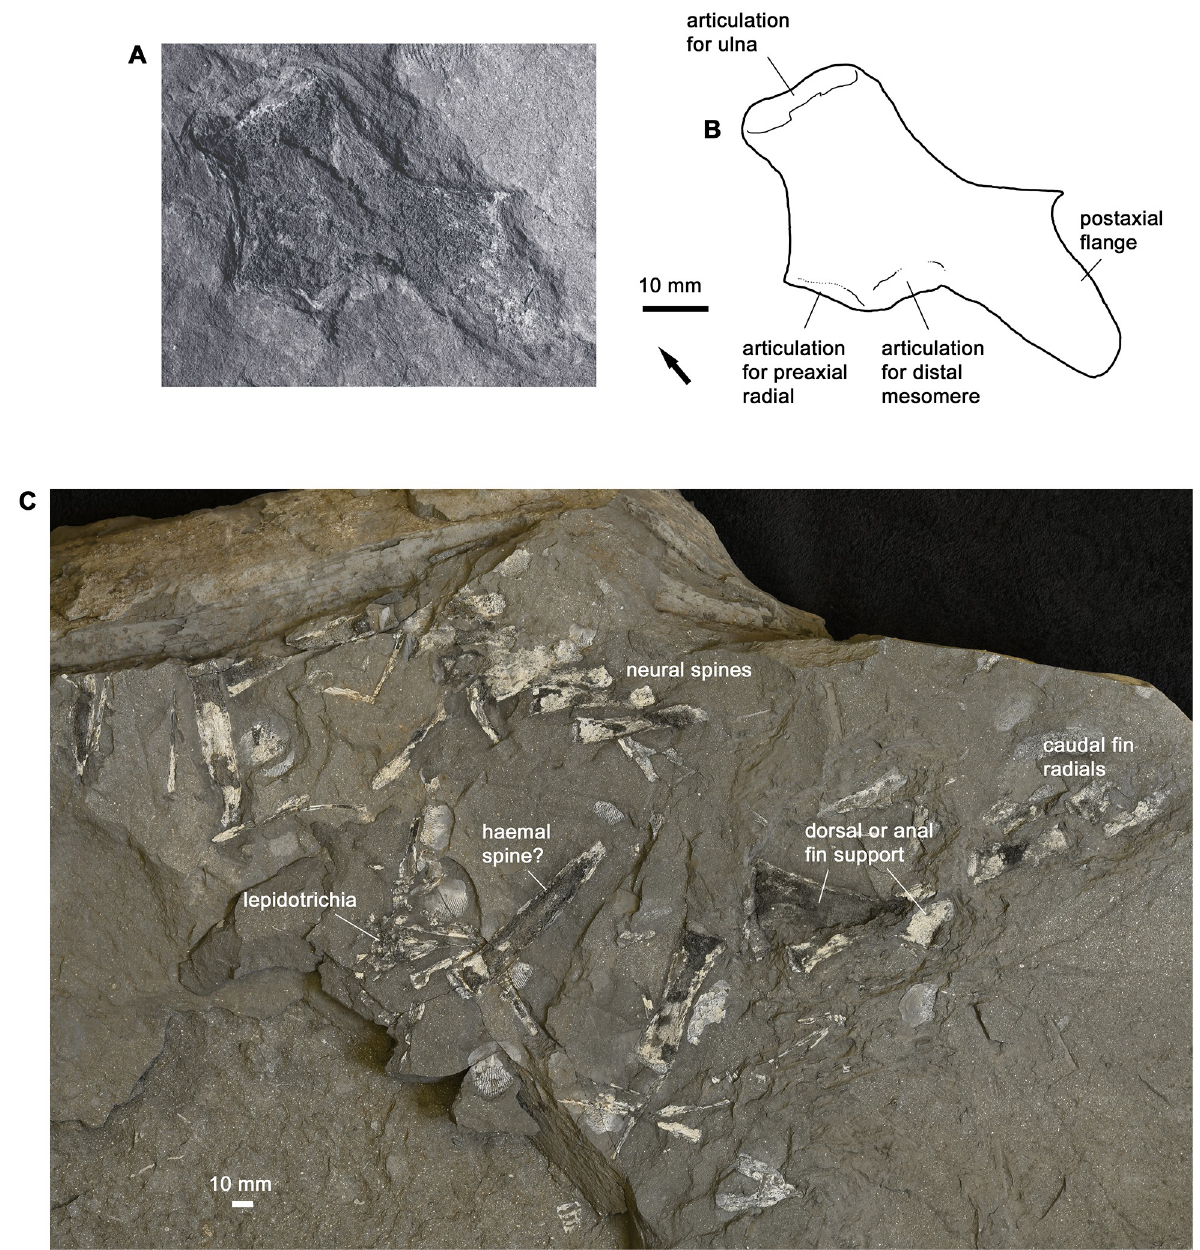
Fig 11. Postcranial endoskeleton. A-B, photo and interpretative drawing of ulnare AM4868. C, photo of scattered axial elements from the posterior part of the body, AM18002. Graphic conventions as in Fig 4.